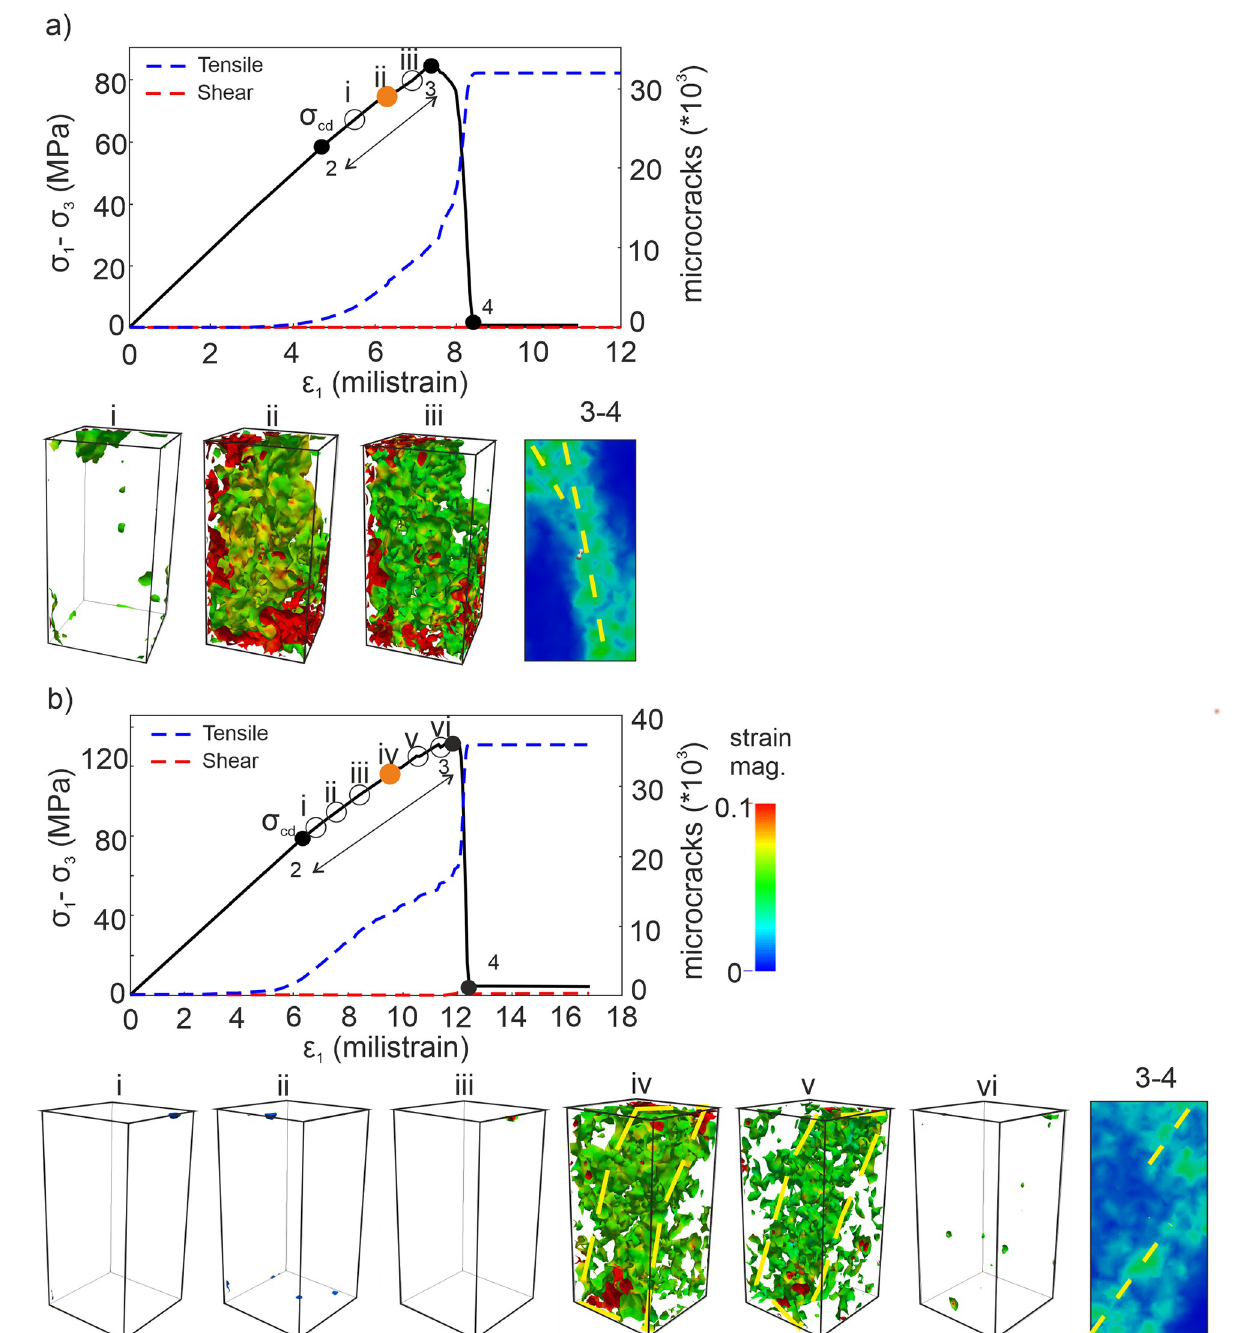
Fig 8. Stress-strain responses and incremental strain fields computed for different substages that divided along the stage 2–3 in the DEM analyses. (a) σ 3 = 0.1 MPa (b) σ 3 = 2